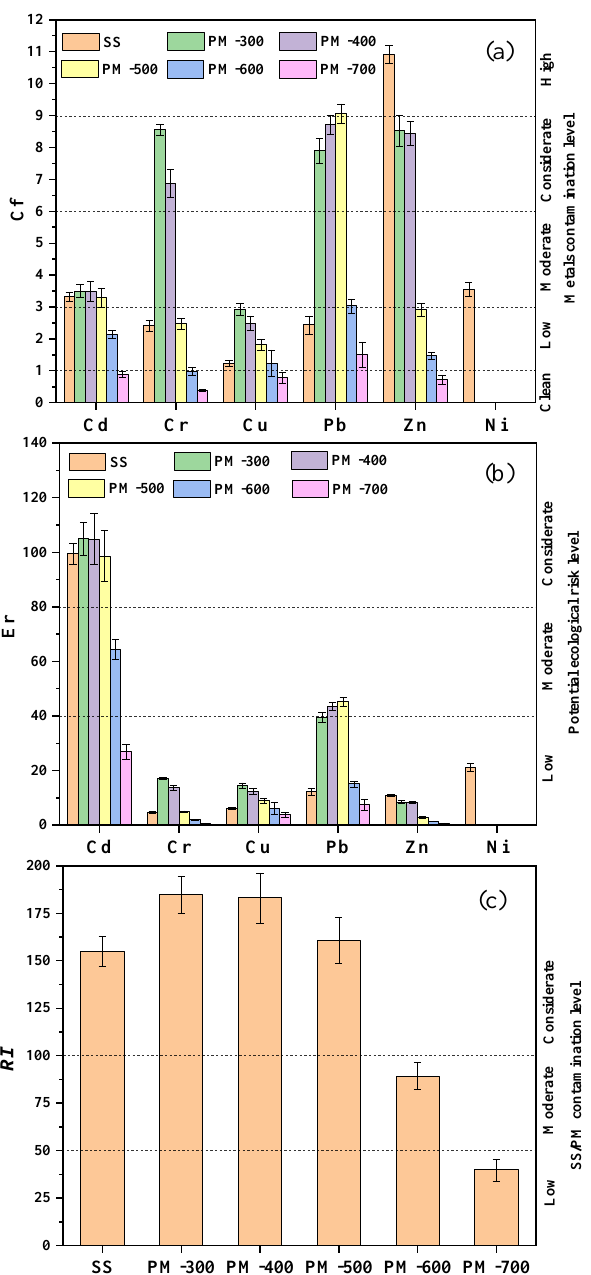
Figure 6. Ecological risk assessment of the heavy metals in the SS and PM. ( a ) contamination factor of the individual heavy metal; ( b ) potential ecological risk factor for the individual heavy metal; ( c ) the sum of the potential ecological risk index (Er) of each heavy metal. PM-X, PM derived from sewage sludge pyrolysis at X (°C) temperature.